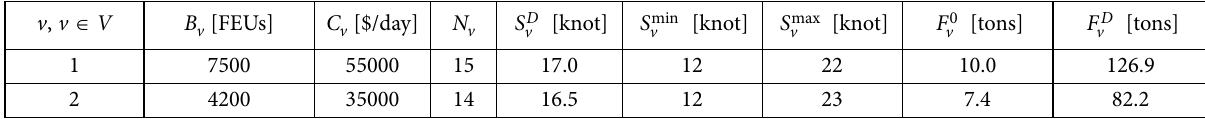
Table 2. Parameters of fleets